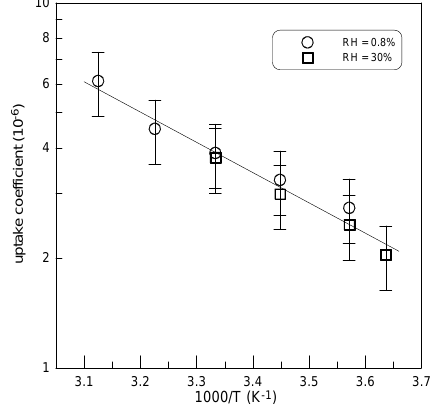
Fig. 9. Temperature dependence of the uptake coefficient mea- sured at T =275–320K under 0.8 and 30% relative humidity: ∼= 0.006s − 1 , sample mass=0.34mgcm − 1 , [NO P = 9Torr, J NO 2 ≈ 2 × 10 12 moleculecm − 3